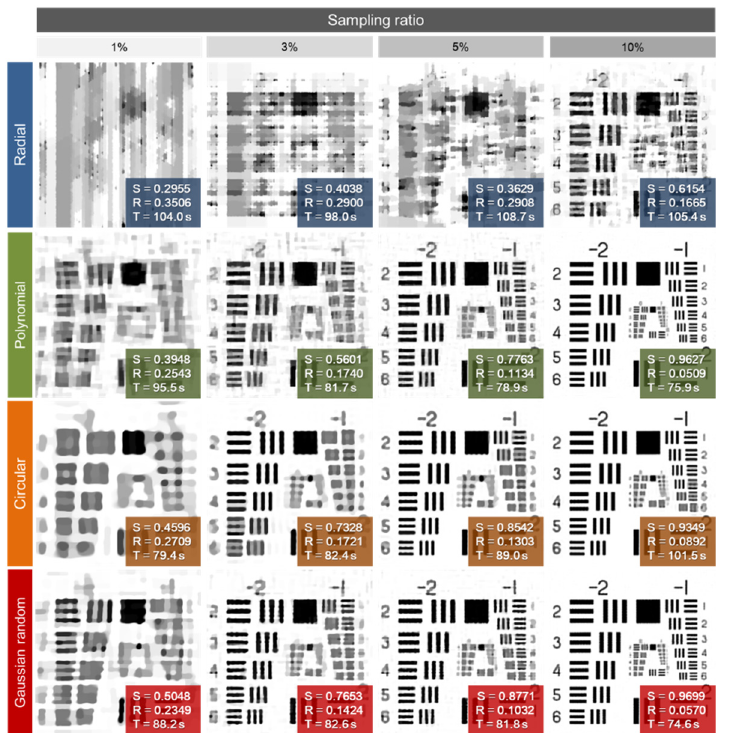
Figure 4. Comparison of the reconstruction results of USAF-1951 resolution test chart for different sampling strategies and sampling ratios. The SSIM, RMSE, and image reconstruction time (denoted by S, R, and T, respectively) are given in the inset of each reconstruction.